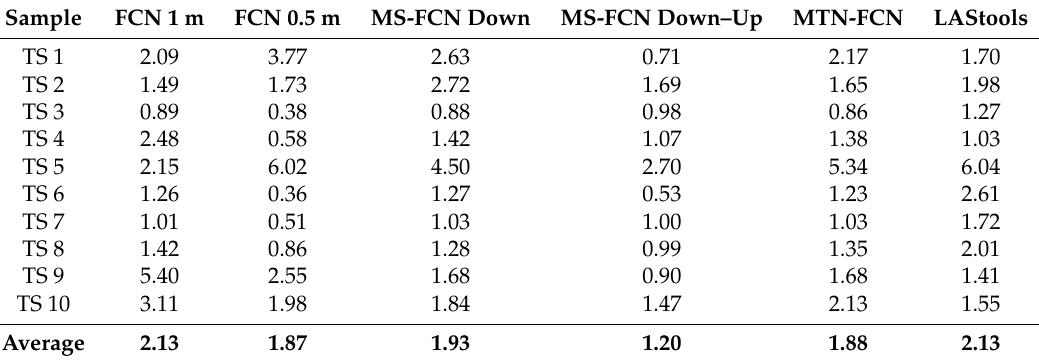
Table 6. Type-I errors of the AHN3 dataset.